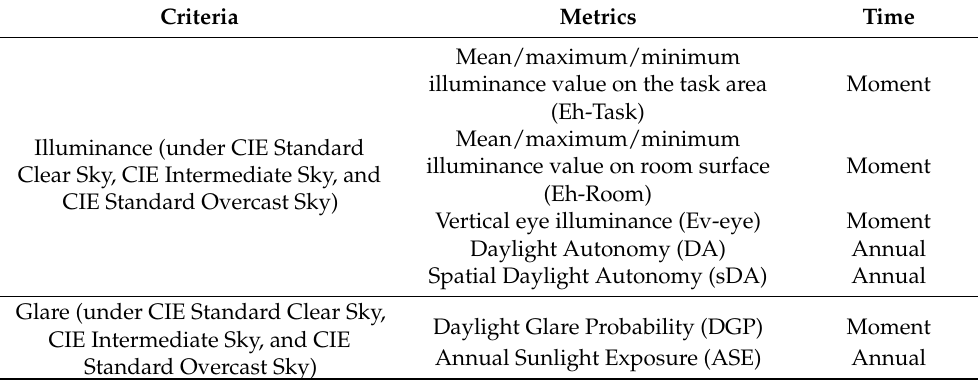
Table 3. Collected visual comfort metrics (daylighting).